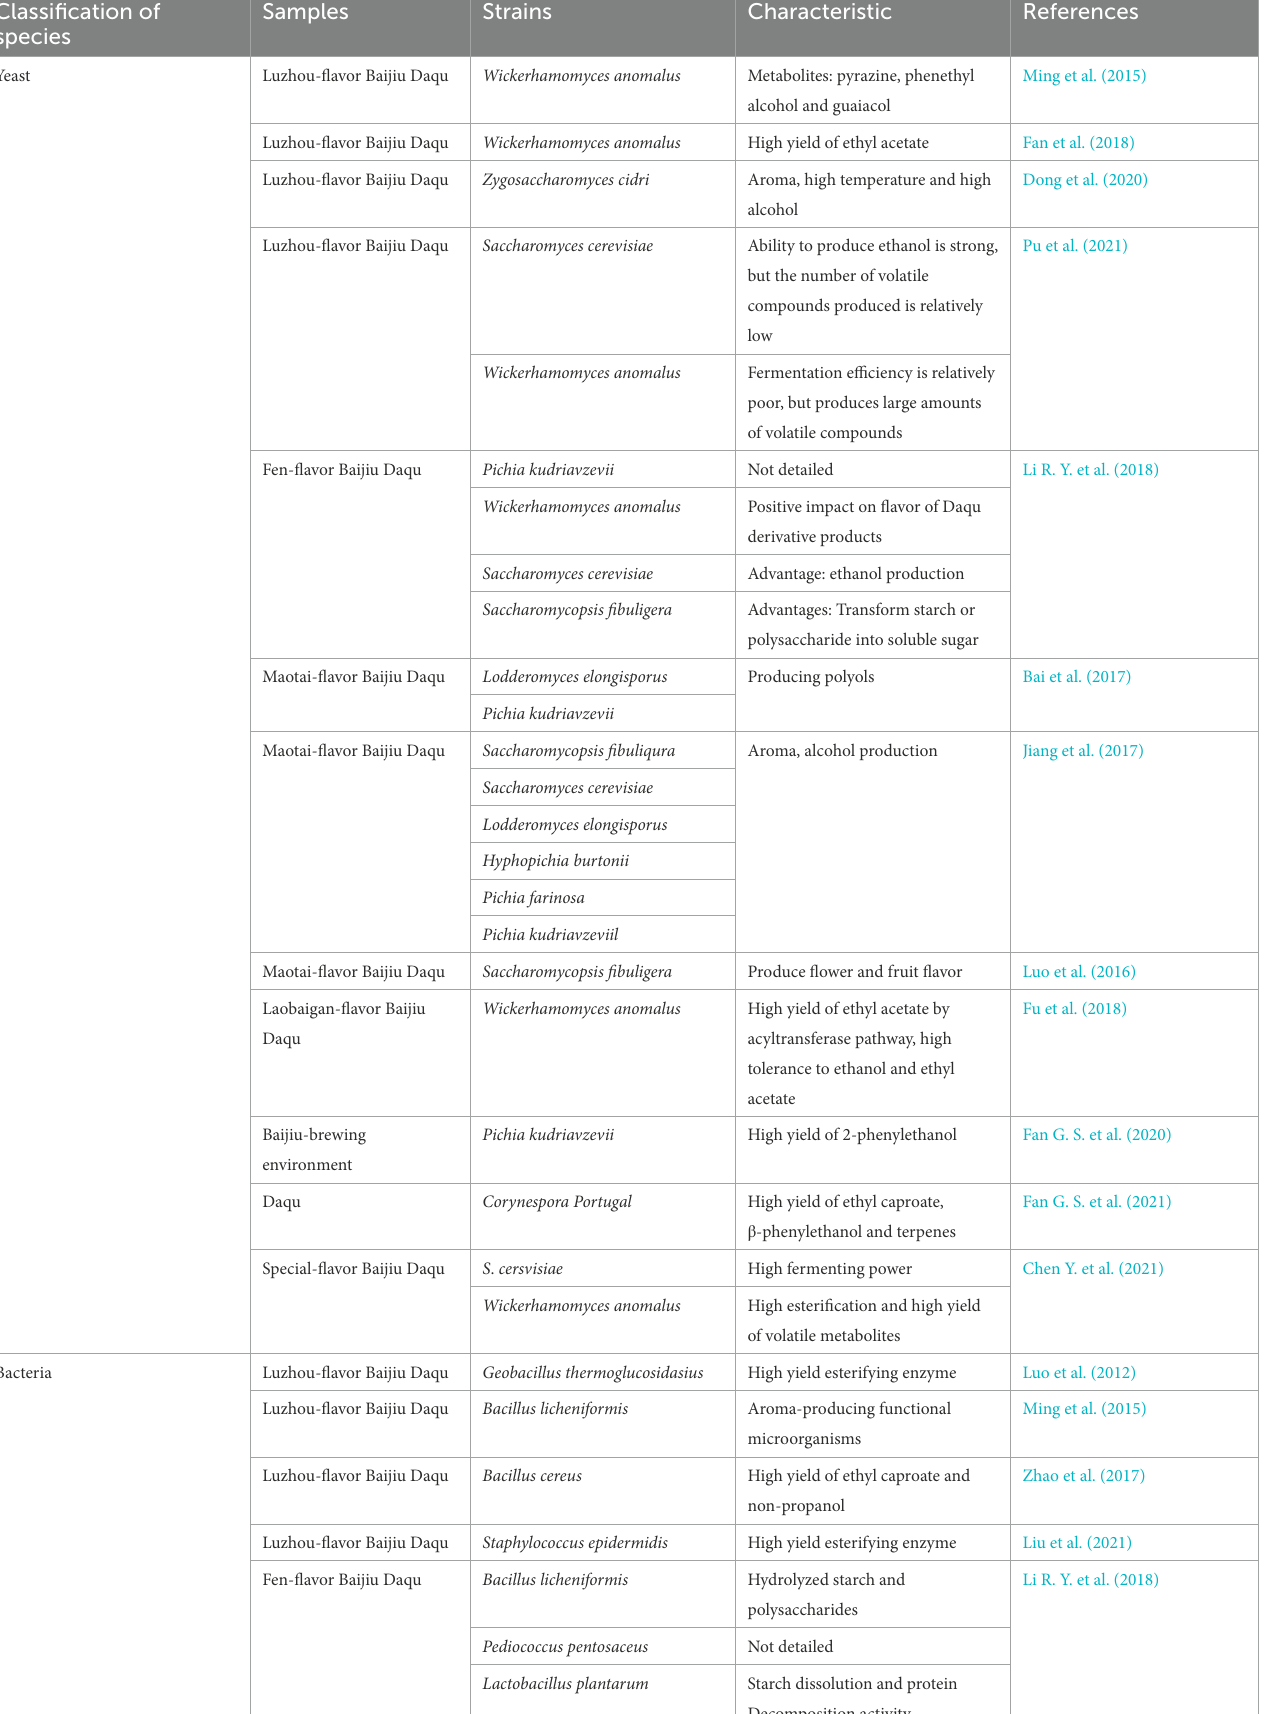
TABLE 1 Isolation, identification, and functional characteristics of Baijiu-brewing functional microorganisms. Classification of